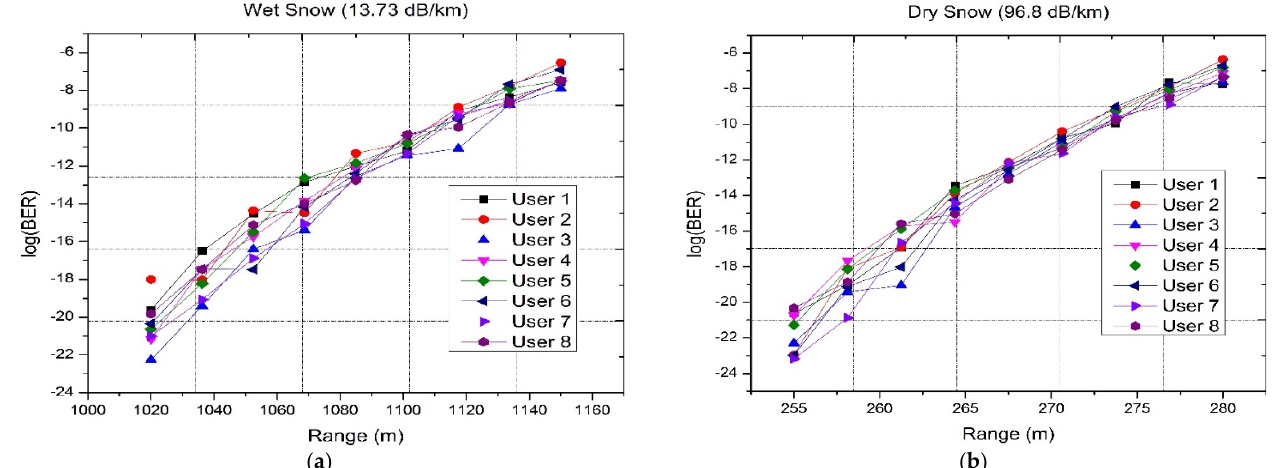
Figure 12. Log (BER) of FSO-PDM/PV-OCDMA system versus FSO link under ( a ) DS, and ( b ) WS.